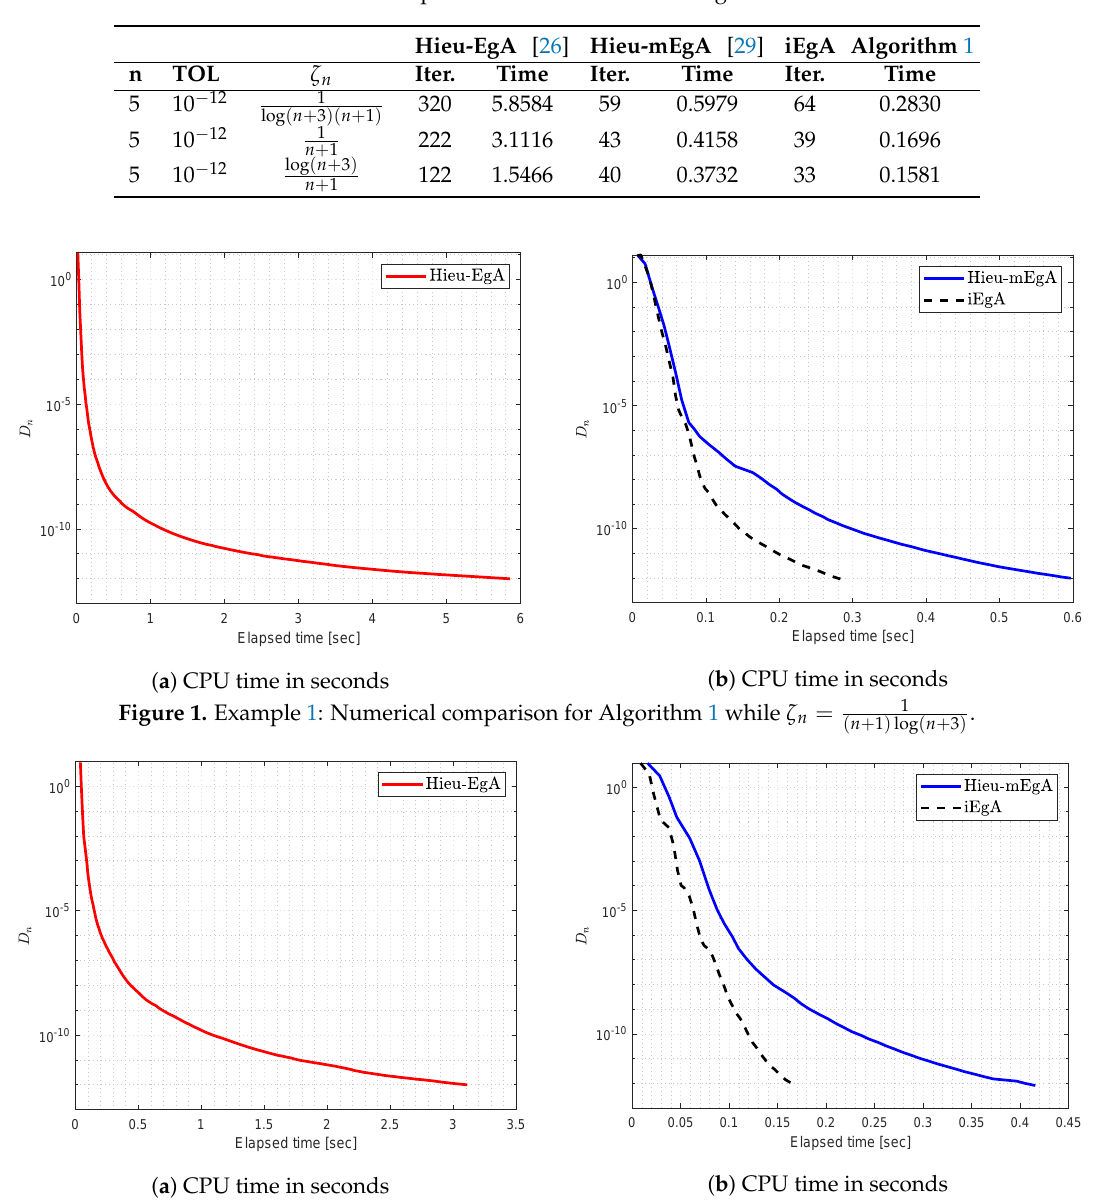
Figure 2. Example 1: Numerical comparison for Algorithm 1 while ζ n = 1